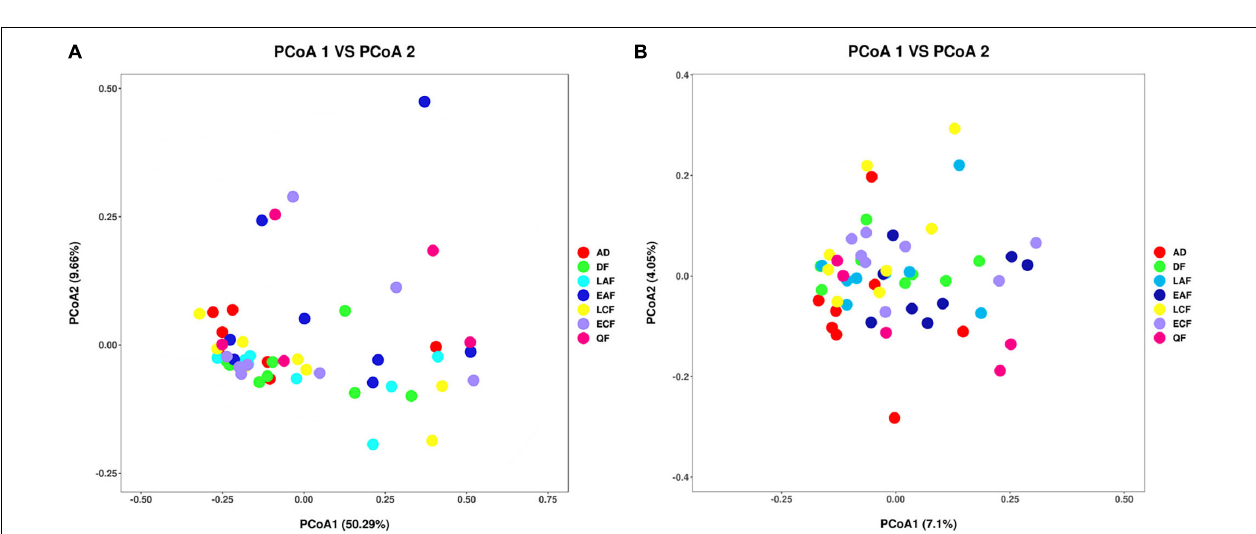
FIGURE 2 | Alpha diversity of microbial communities in the F. tinnunculus gut. Data plotted show the means ± SE of the Shannon index (A) and number of observed OTUs (B) based on rarefaction plots ( Supplementary Figure 1 ). AD refers to eight samples from the adult birds; DF refers to eight samples from the downy feather stage; EAF refers to eight samples from the early acicle feather stage; LAF refers to eight samples from the later acicle feather stage; ECF refers to eight samples from the early contour feather stage; LCF refers to eight samples from the later contour feather stage; QF refers to five samples from the qi feather stage.